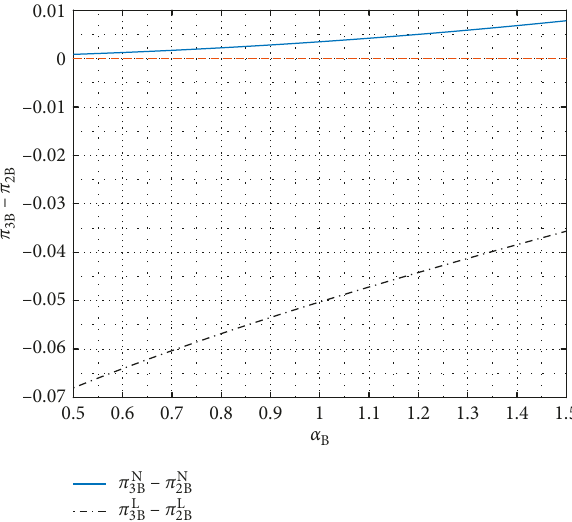
Figure 14: Impact of subsidy on manufacturer